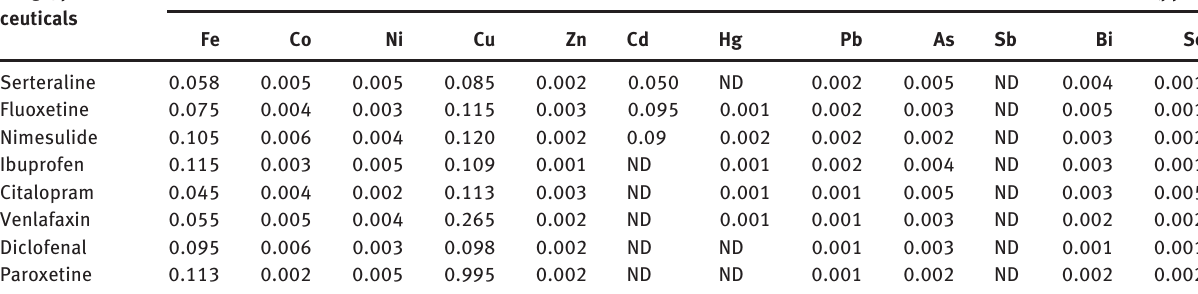
Table 6 Determination of trace metal in drugs/pharmaceuticals. ND, not